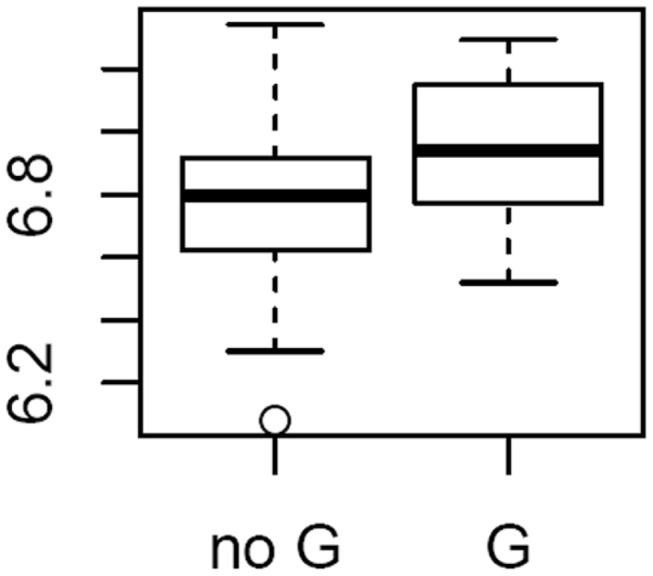
rs10786775 genotype associates with OBFC1 expression in adventitial aortic tissue.
OBFC1 expression level by rs10786775 genotype. Sample distribution was 115 no G // 18 G (17GC+1 GG).